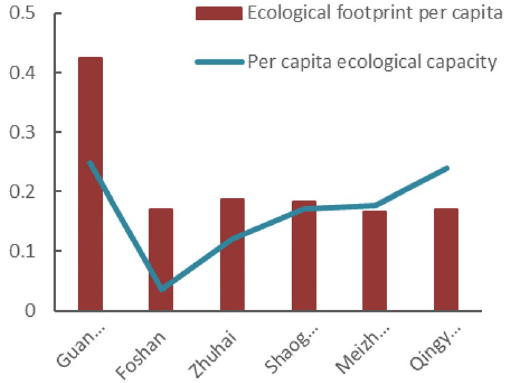
Figure 8. Analysis of ecological footprint of cities in 2018.